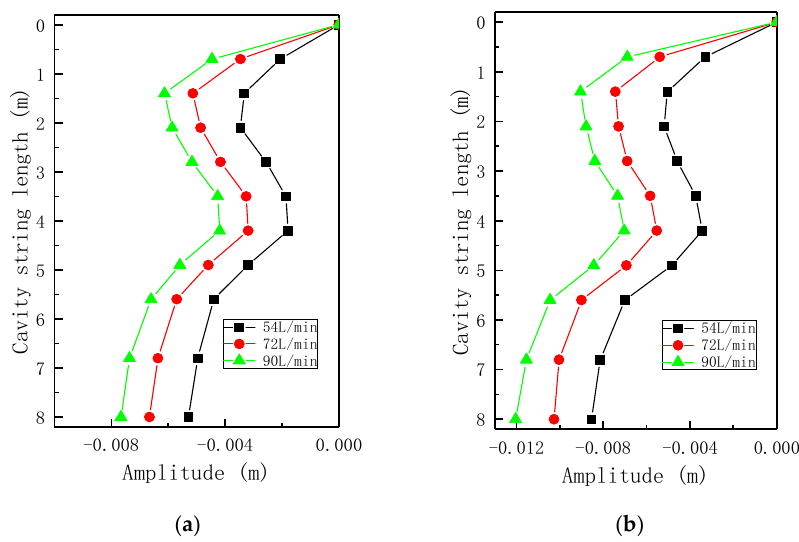
Figure 12. Vibration deformation diagrams of the inner leaching tubing with different water injection rates. ( a ) Direct circulation; ( b ) reverse circulation.